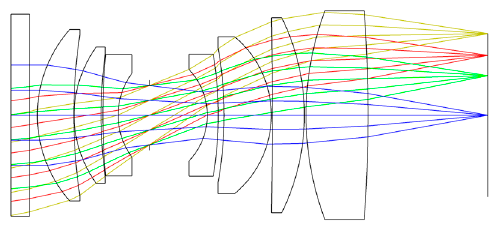
Figure 2. The structure of the optical system.